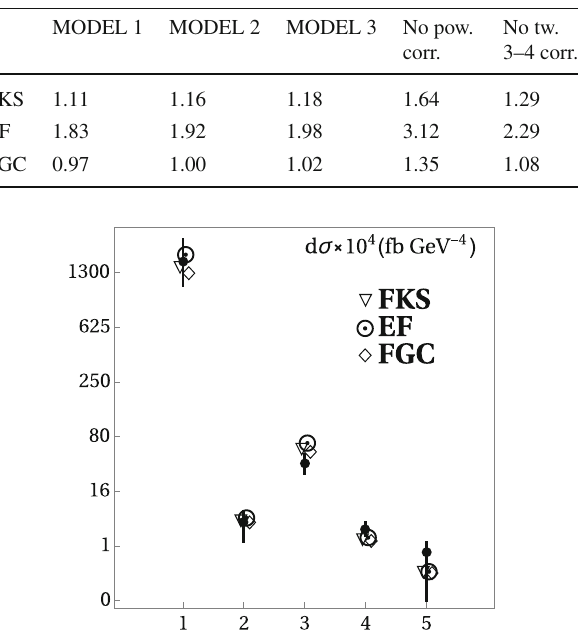
Table 1 Values of χ 2 / #points evaluated for different theoretical inputs in MODEL 1. The fifth and sixth columns represent values without power corrections (both mass and higher twist) and without higher- twist corrections, respectively